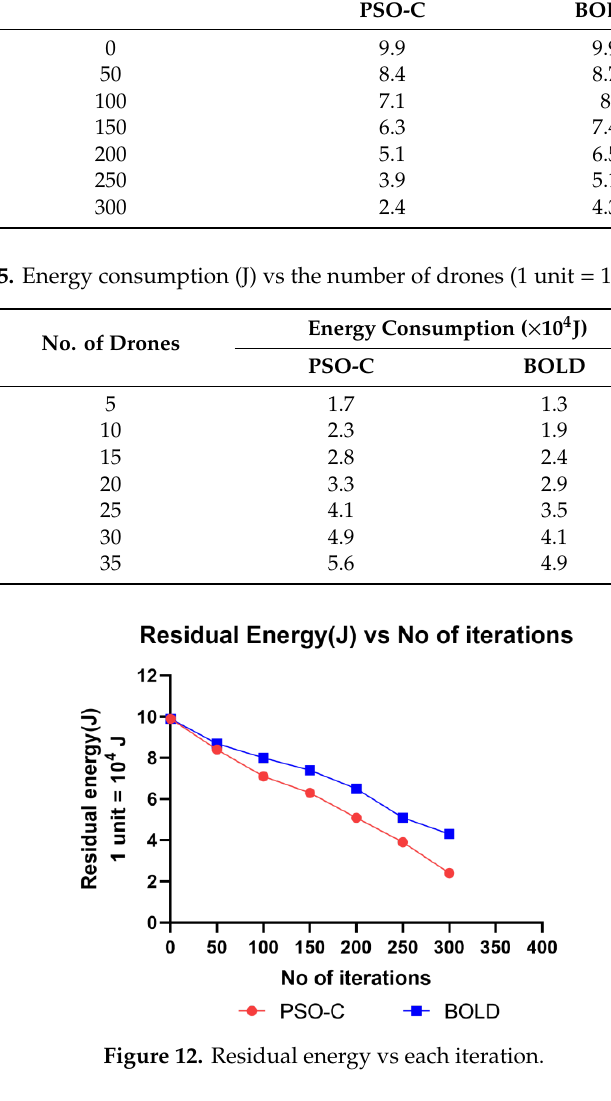
Figure 13. Energy consumption vs. the number of drones. Table 5. Energy consumption (J) vs the number of drones (1 unit = 10 4 Joules). No. of Drones Energy Consumption (×10 4 J) PSO-C